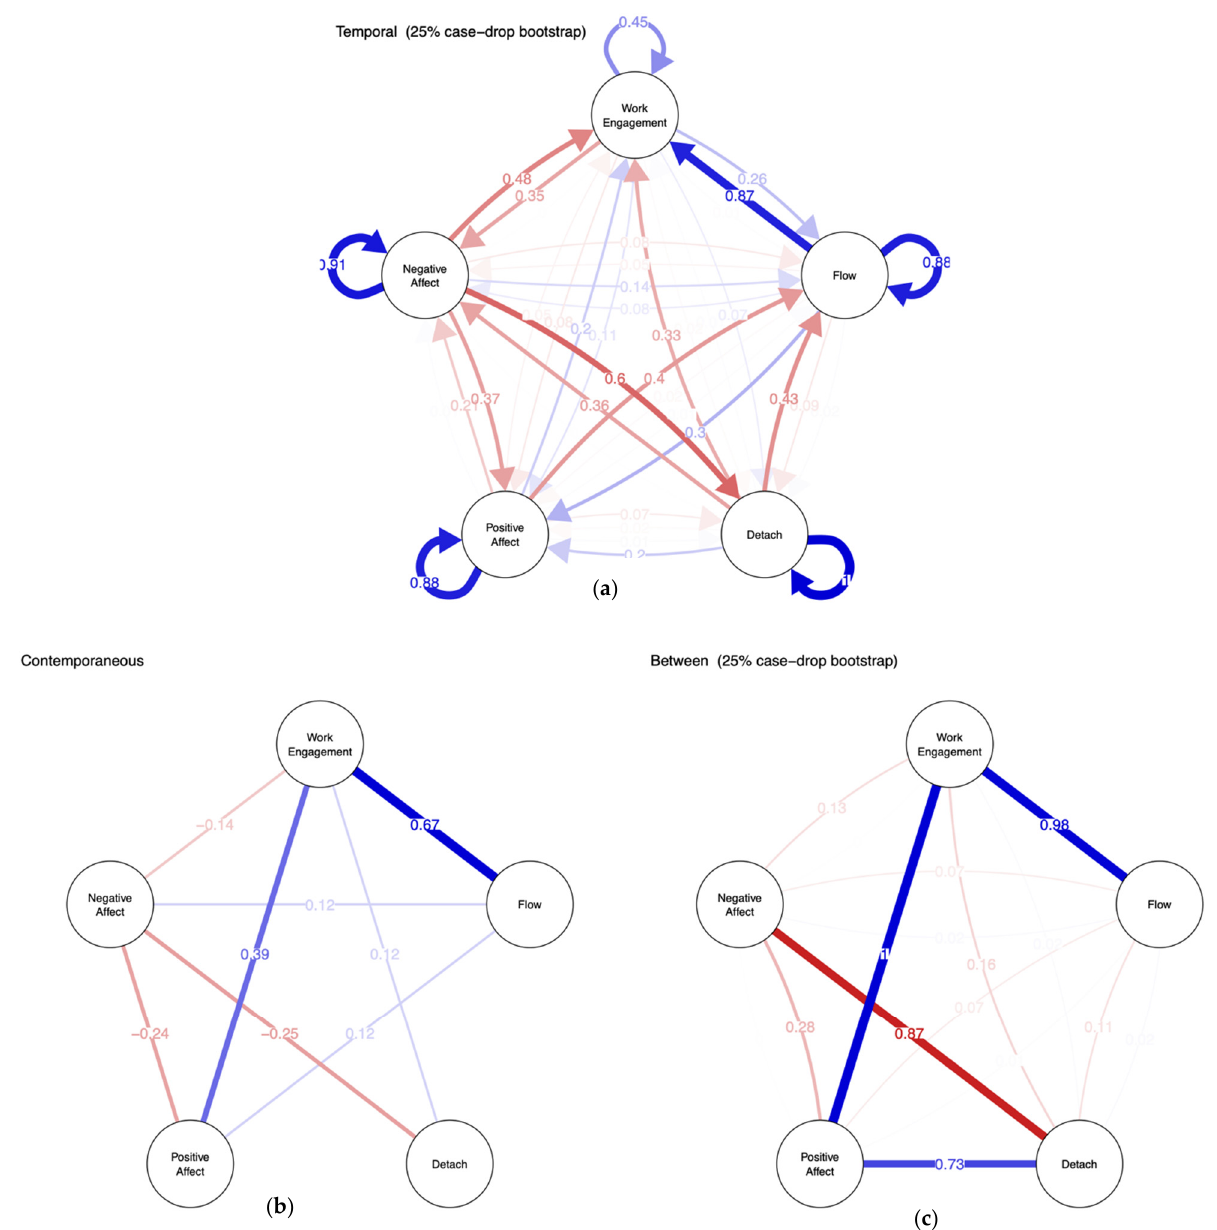
Figure 3. Stability measures of the temporal ( a ), contemporaneous ( b ), and between-subject ( c ) network. Edge weight indicates the inclusion proportions of each edge in 1000 times case-drop bootstrap (25%). Blue and red edges indicate positive and negative associations, respectively.